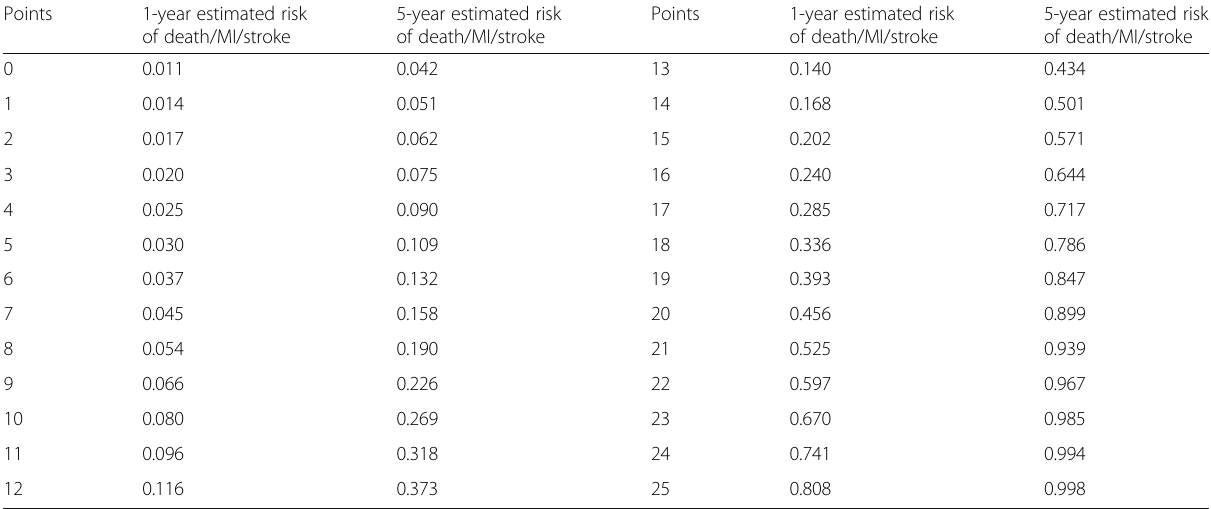
Table 5 Estimated risk by point score Points